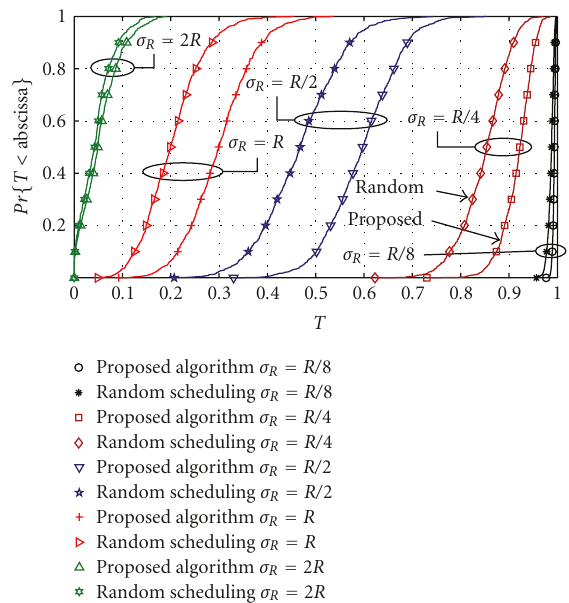
Figure 5: CDF of network throughput T for random and proposed